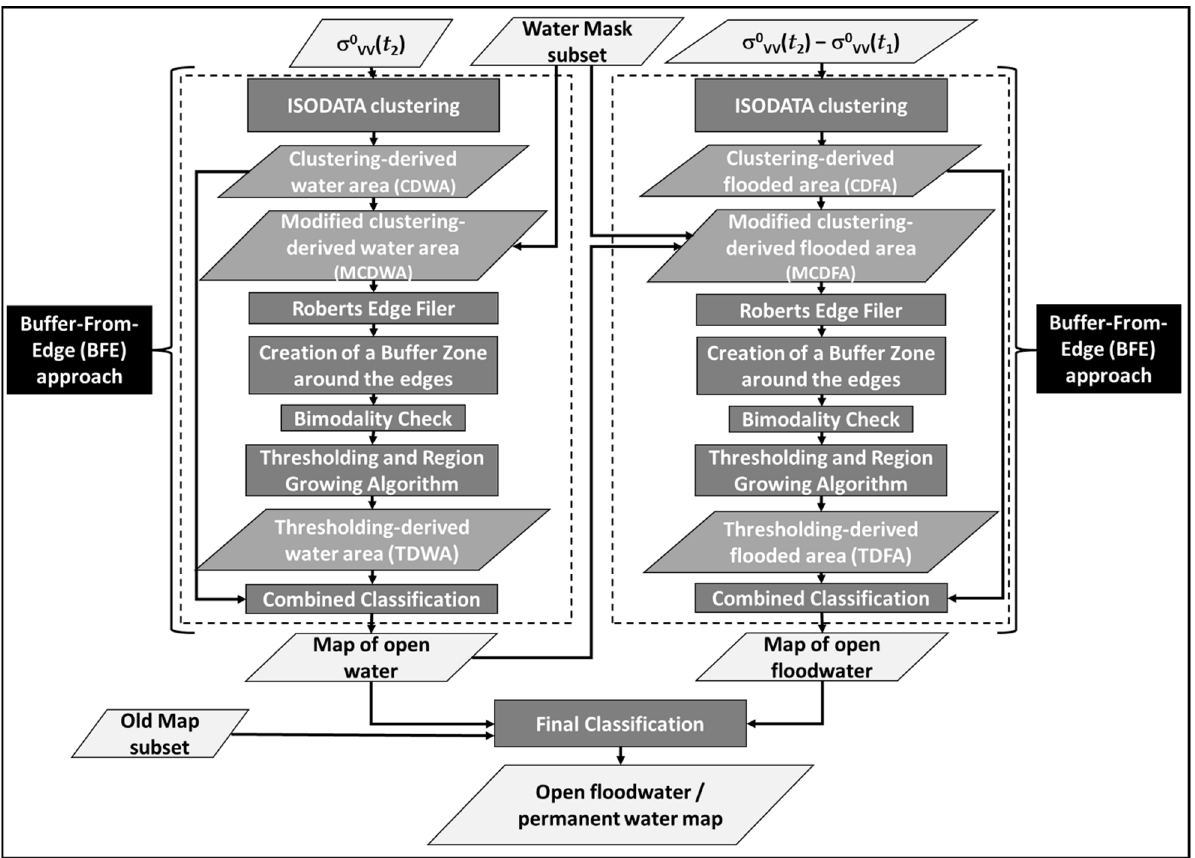
Figure 7. Flowchart of the open water mapping algorithm implemented in AUTOWADE. Dark gray rectangles represent operations; parallelograms represent data (light gray: input/output data, dark gray: intermediate data).